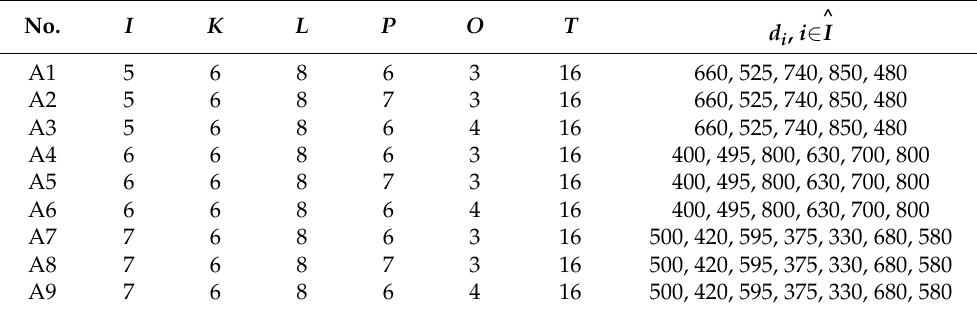
Table 9. The additional test